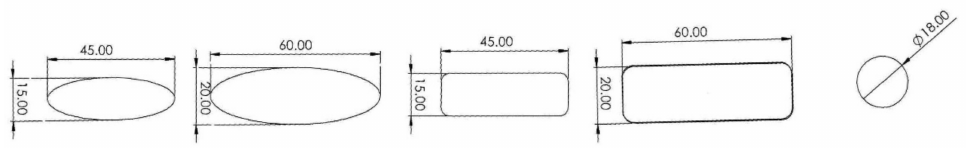
Figure 9. Seat stay cross-sections from left to right: oval 10 × 30, oval 17 × 30, rectangular 10 × 30, and circular 12 mm.